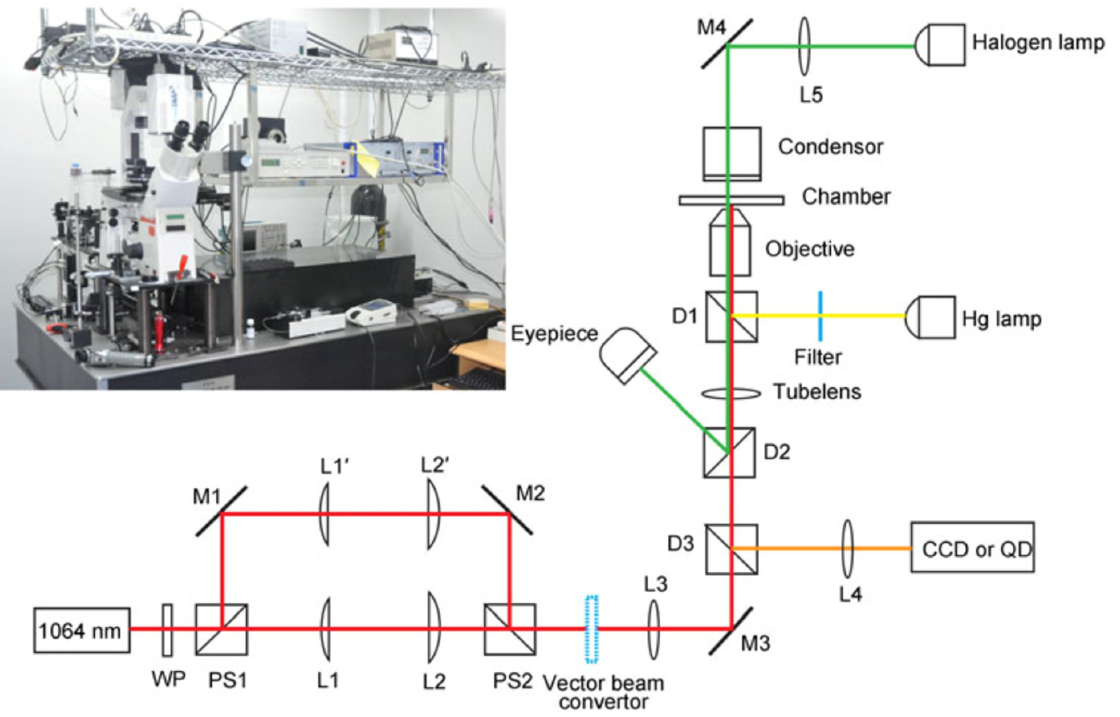
Figure 1. Schematic of an Optical Tweezer. This optical tweezer setup showcases the conventional standard for optical trapping assays, which are generally carried out in conjunction with a Nikon camera as well as mercury and halogen lamps [1]. Reprinted with permission from Ref. [1]. Copy- right © 2022 Springer Nature Switzerland AG. Part of Springer